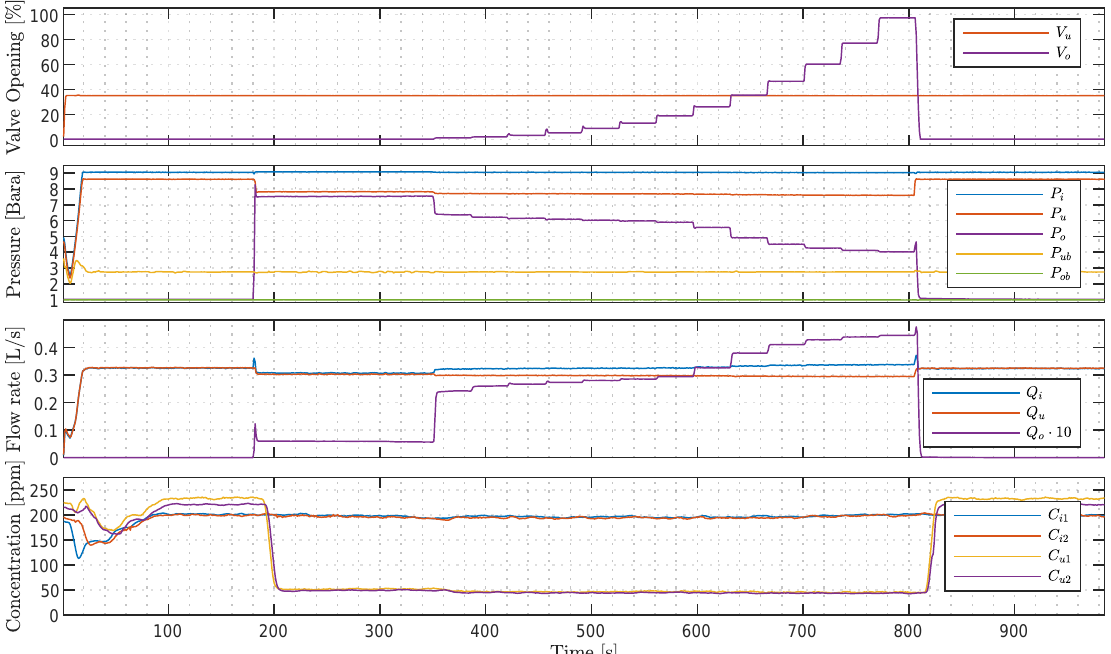
Figure 20. Valve openings, pressures, flow rates, and OiW concentrations during a segment of the grid experiment with V u = 37.5% open and WP = 100% speed. The hydrocyclone is bypassed from 0–180 s and from 805–985 s to provide a time-window before and after the stepping where no separation occurs. The first step of V o is held from 180–280 s to settle the system, and from here V o increases in opening every 35